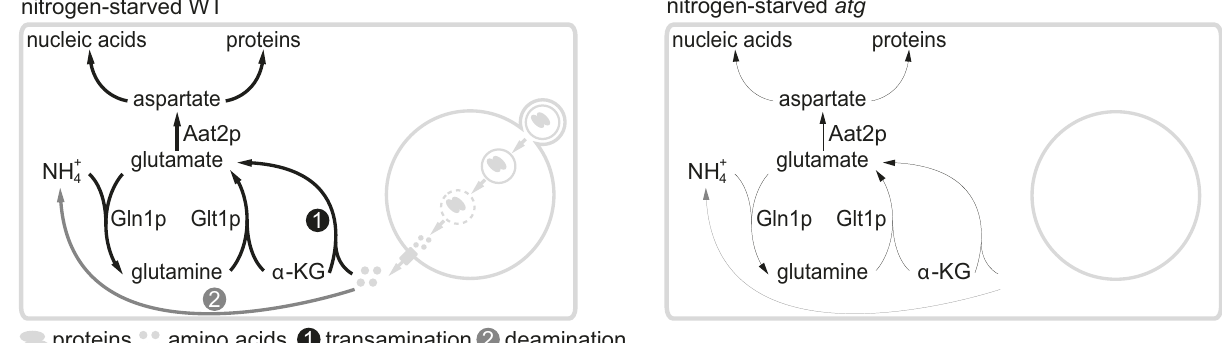
Fig. 9 Model. Under nitrogen starvation, autophagy allows yeast cells to retrieve nitrogen to support glutamate synthesis via a complex nexus of transamination and deamination reactions. This replenishes cellular nitrogen currency for subsequent nitrogen anabolism such as aspartate synthesis to support macromolecule synthesis. Although not speci fi cally depicted here, amino acids derived directly from protein turnover may also participate in macromolecule synthesis under nitrogen